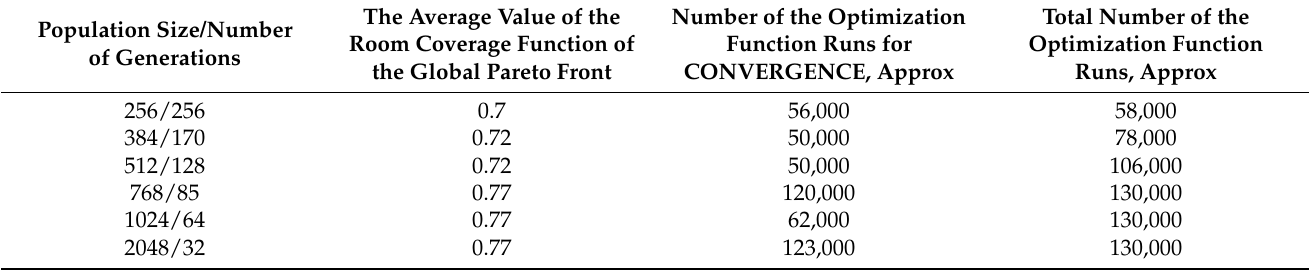
Table 8. Comparison of the combination of population size and number of generations for 2